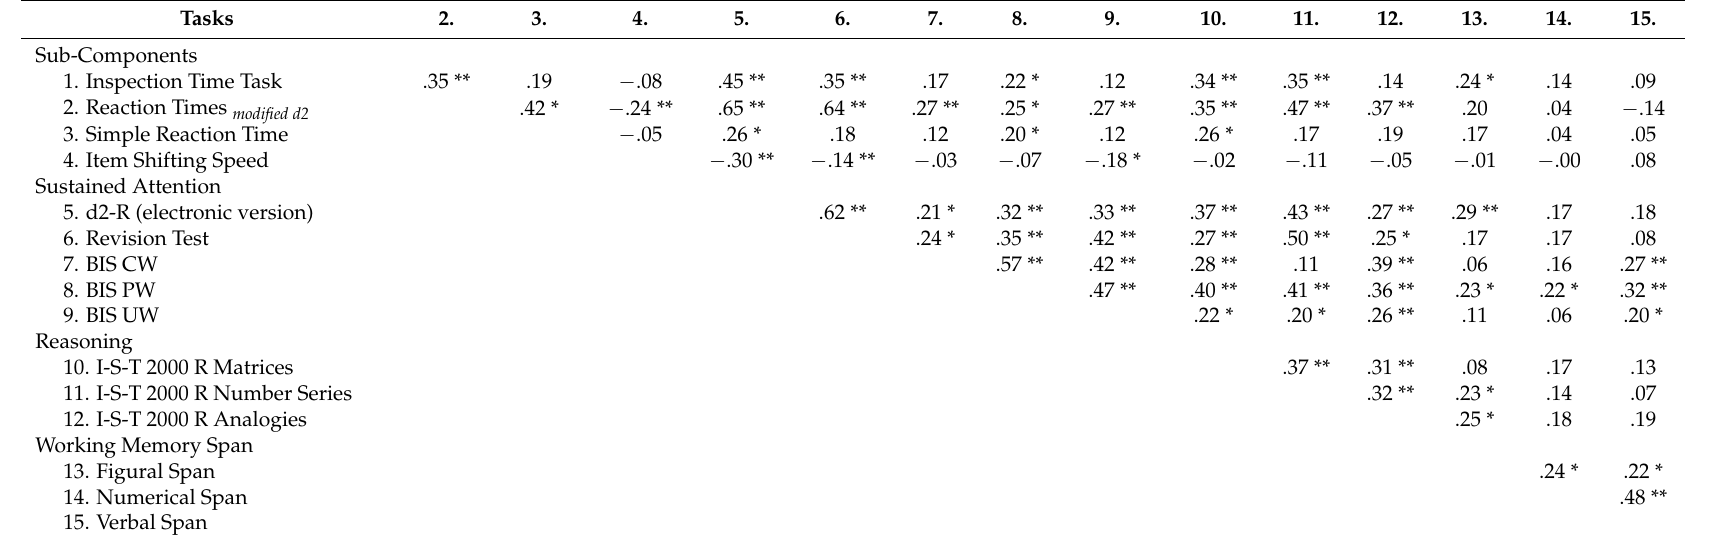
Table A1. Correlation matrix of the measures in Study